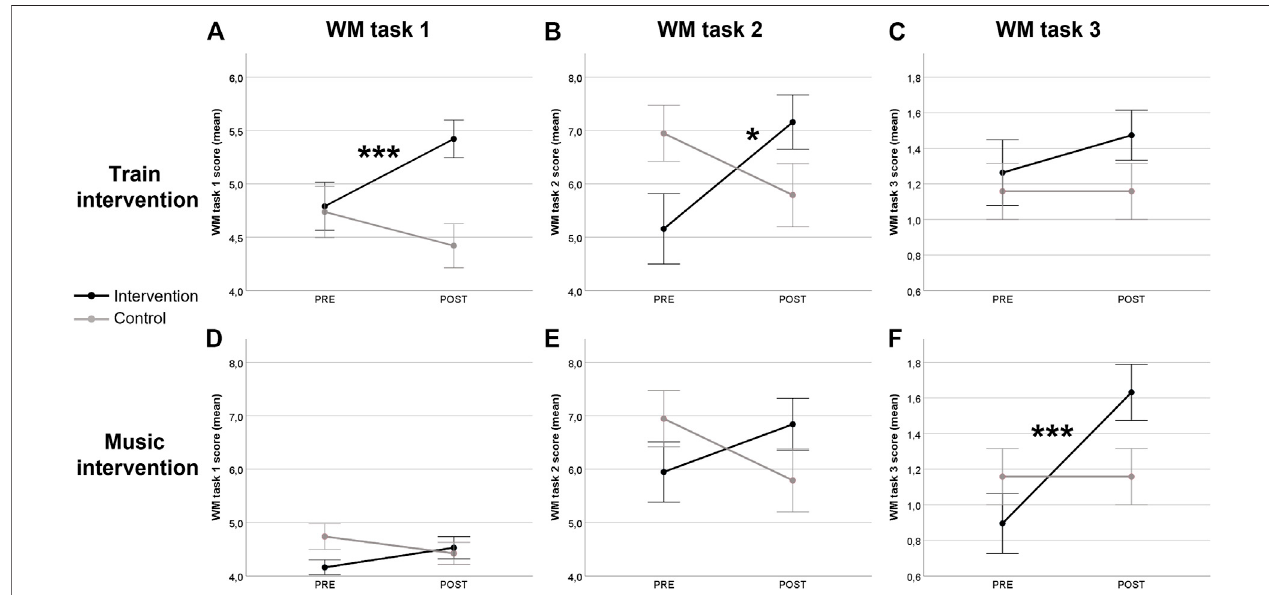
FIGURE 3 | Pre- and post-intervention scores in working memory tasks 1, two and 3. Mean score ( ± SEM) on the working memory task 1 (A – D) , 2 (B – E) and 3 (C – F) before (PRE) and after (POST) the train and the music intervention in comparison to the control condition. POST, post-intervention; PRE, pre-intervention; WM, Working Memory; # p < 0.05 and ## p < 0.01 for post-hoc tests comparing pre-vs post-intervention scores when interaction was signi fi cant.